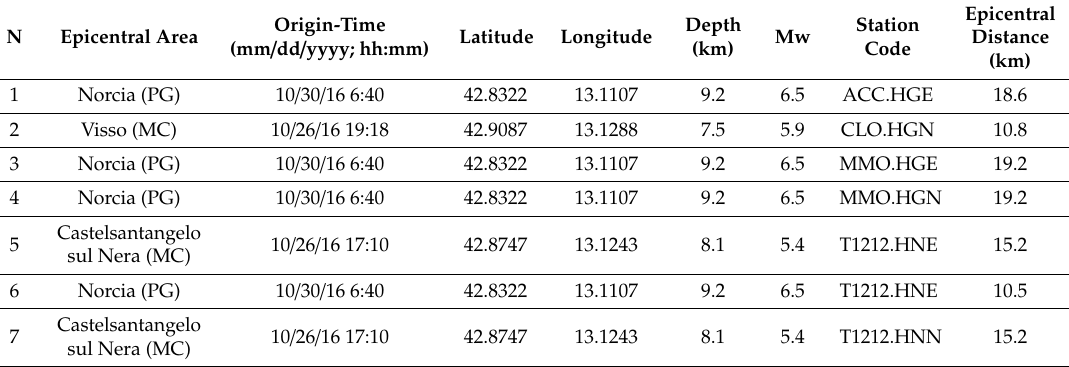
Figure 5. Not scaled accelerometric time series selected with REXELite tool, as representative of earthquakes scenario for the historical center of Avellino. Numbers in the small boxes indicate the event-numbers listed in the Table 4. Table 4. List of seismic events, which produced the accelerometric waveforms chosen for this study.